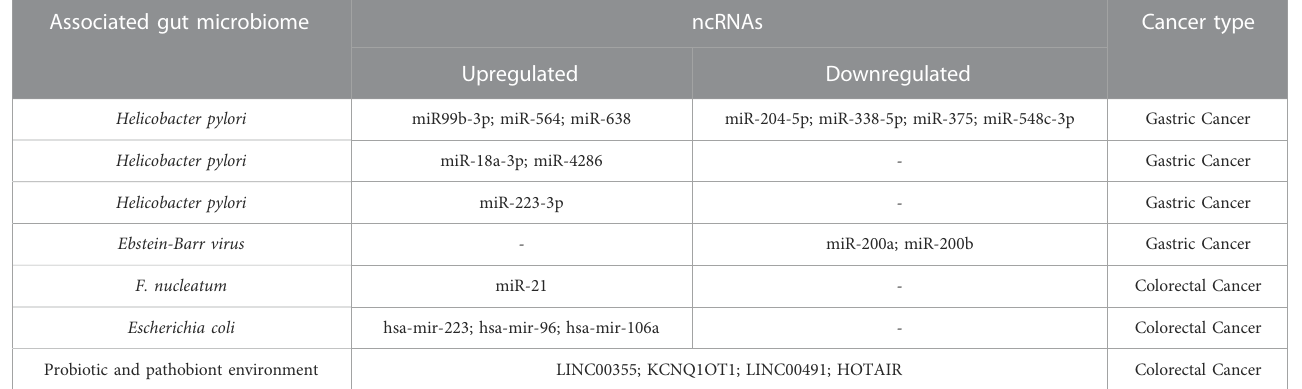
TABLE 2 Gut microbiome-associated ncRNAs and GI